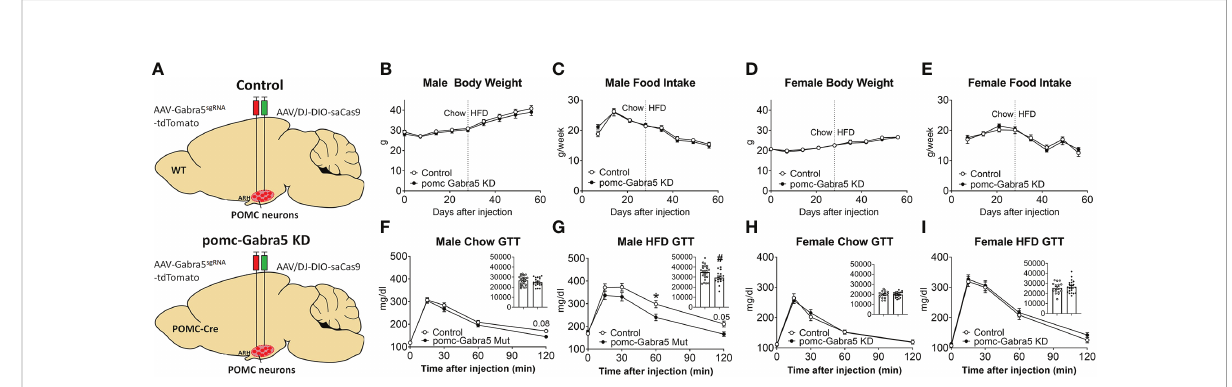
FIGURE 6 pomc-Gabra5 KD male mice developed glucose intolerance. (A) Generation of pomc-Gabra5 KD and controls by stereotaxic injection of AAV- Gabra5 sgRNA -tdTomato virus and AAV/DJ-CMV7-DIO-saCas9 virus together into the ARH of POMC-Cre mice or their wild type littermate mice. (B – E) Weekly body weight (B, D) and food intake (C, E) in male (B, C) and female (D, E) pomc-Gabra5 KD and control mice. (F – I) GTT in male (F, G) and female (H, I) pomc-Gabra5 KD and control mice fed with chow diet for 4 weeks after injection (F, H) or HFD for 4 weeks (G, I) . Data are presented as mean ± SEM with individual data points. N=15 – 27 per group. Inserted column fi gures are AUC analysis of GTT data, y axis is the arti fi cial units for AUC. # , P < 0.05 in unpaired t-tests. *, P < 0.05 in two-way ANOVA followed by post hoc Sidak ’ s tests.